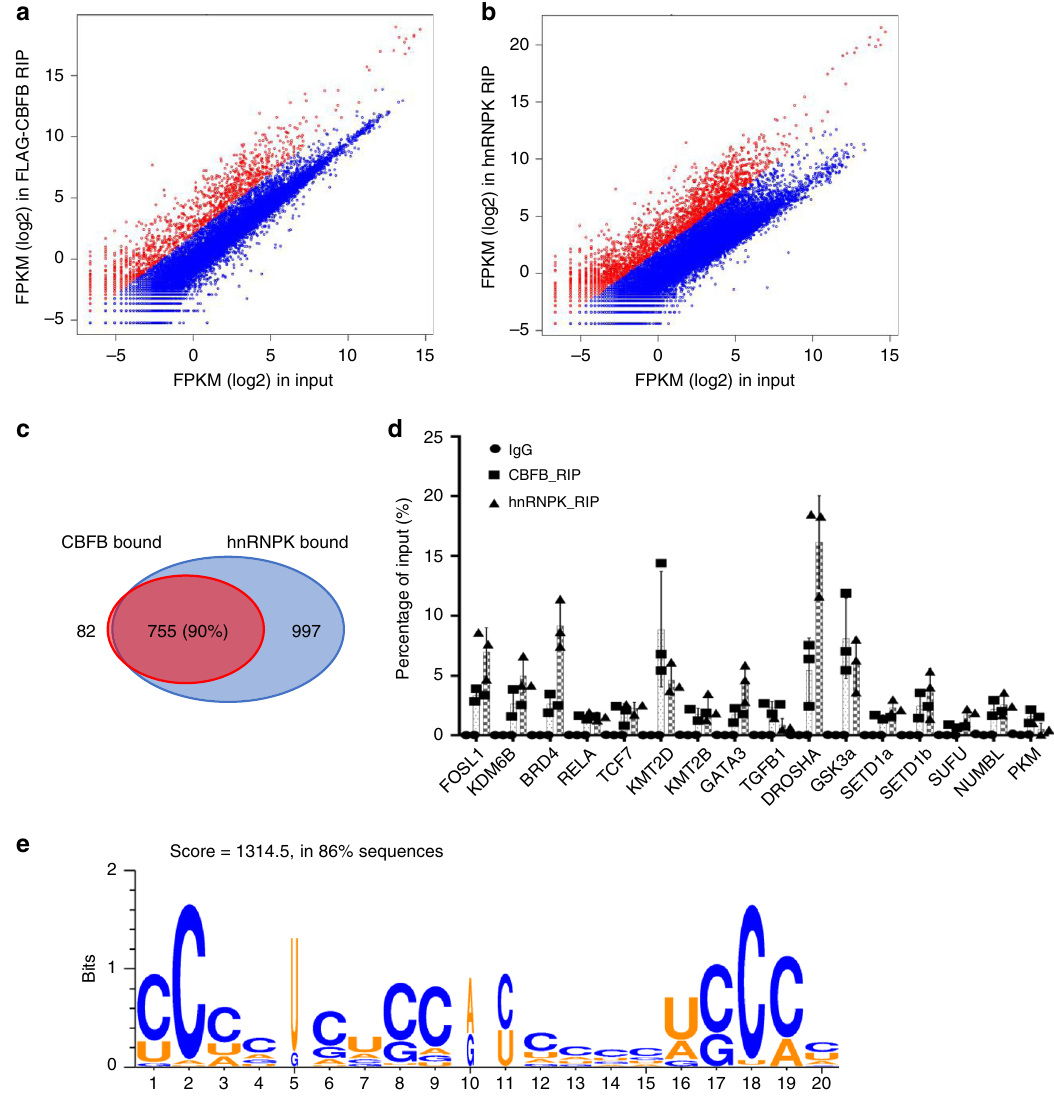
Fig. 3 Genome-wide binding of CBFB and hnRNPK to mRNAs. RIPseq of FLAG-CBFB ( a ) and hnRNPK ( b ) in MCF10A cells. Shown are mean adjusted FPKM + 1 (log2). Red dots show the transcripts that are enriched in FLAG-CBFB RIP more than 4-fold. The rest transcripts are shown as blue dots. c A Venn diagram showing transcripts bound by both CBFB and hnRNPK. d Validation of binding of CBFB and hnRNPK to 16 selected transcripts using RIP followed by real-time PCR. Error bars are SEM, n = 3 (biological). e The top-ranked gapped motif, which was represented in 86% of the hnRNPK